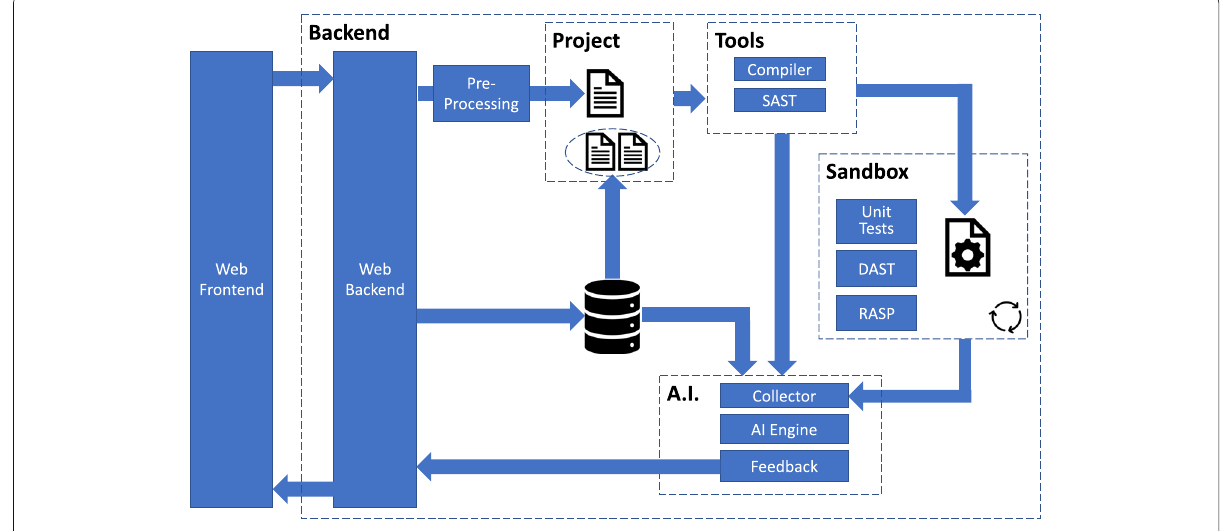
Fig. 6 Detailed architecture: the Sifu Platform